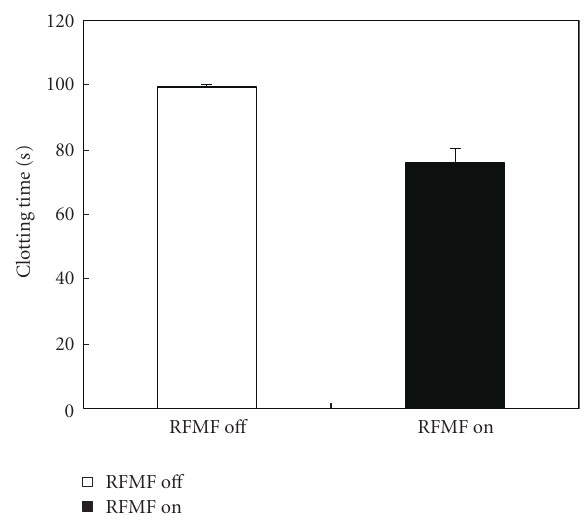
Figure 4: The control of the function of Au-aptamer by RFMF. The white bar termed “RFMF o ff ” shows the clotting time of the mixture after 5min of incubation at room temperature. The black bar termed “RFMF on” shows the clotting time of the mixture of thrombin, fibrinogen, TBA, and 20-mer complementary DNA after 5min of irradiation using RFMF. Each clotting time represents the average of the clotting times in two experiments, and error bars are